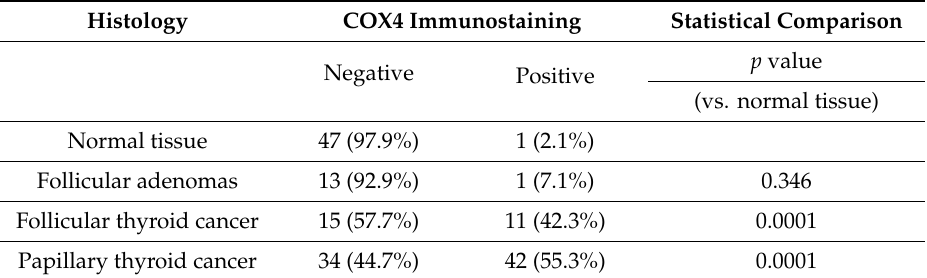
Table 1. Analysis of immunostaining with anti-COX4 in function of histology.